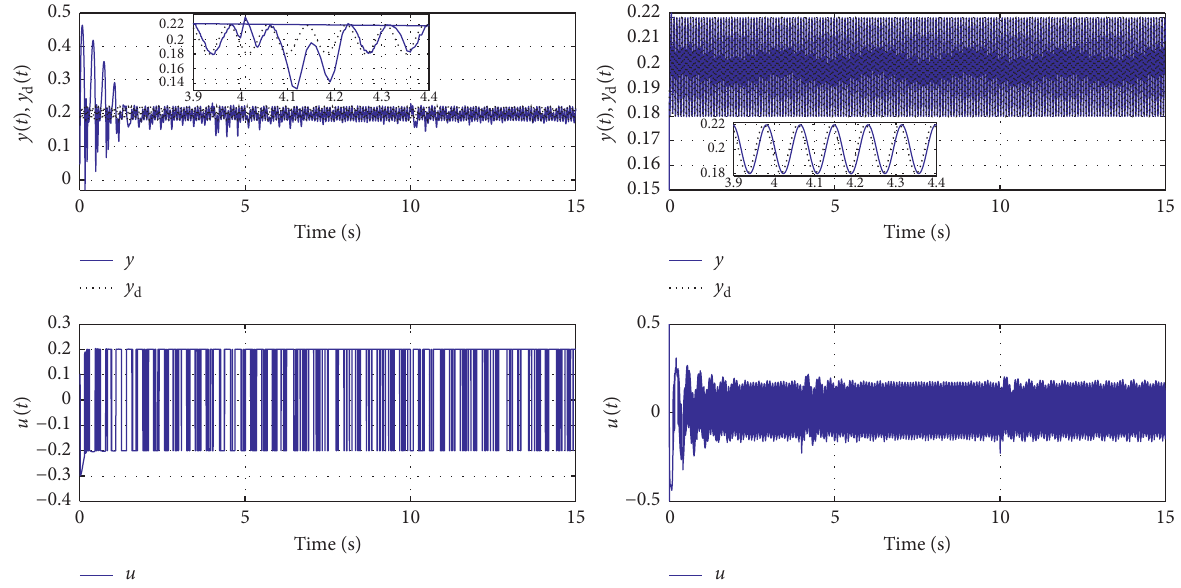
Figure 7: Control performance of NN-NSM and NN-FFOSM in case 2.